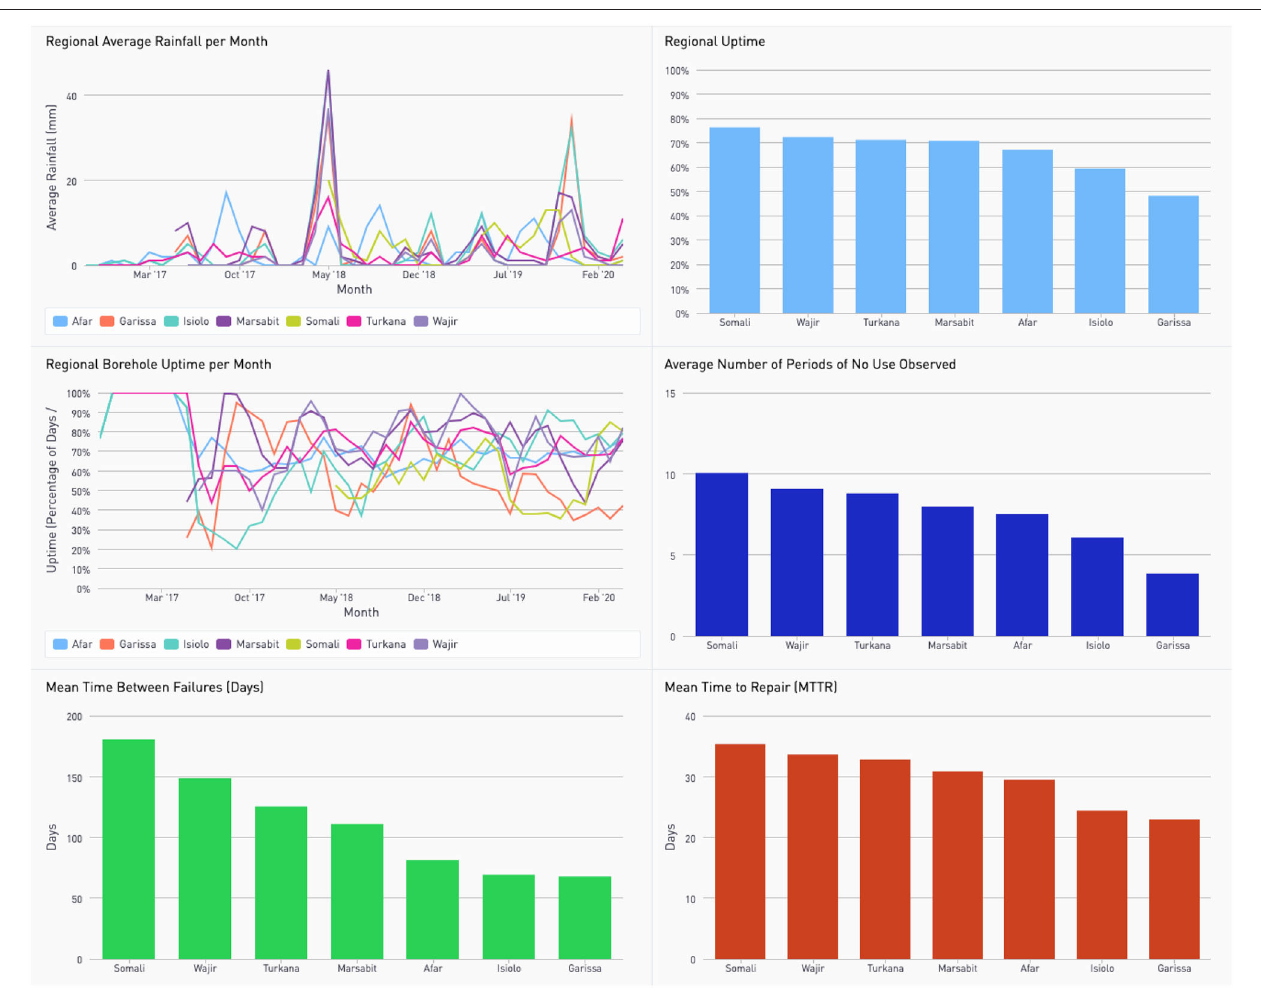
FIGURE 4 | DRIP public analytics includes average borehole runtime per administrative region, rainfall, and estimated mean time between failures and repairs. Detailed analytics for every pump is available to authorized users through password-protected logins. Available through https://prepdata.org/dashboards/the-